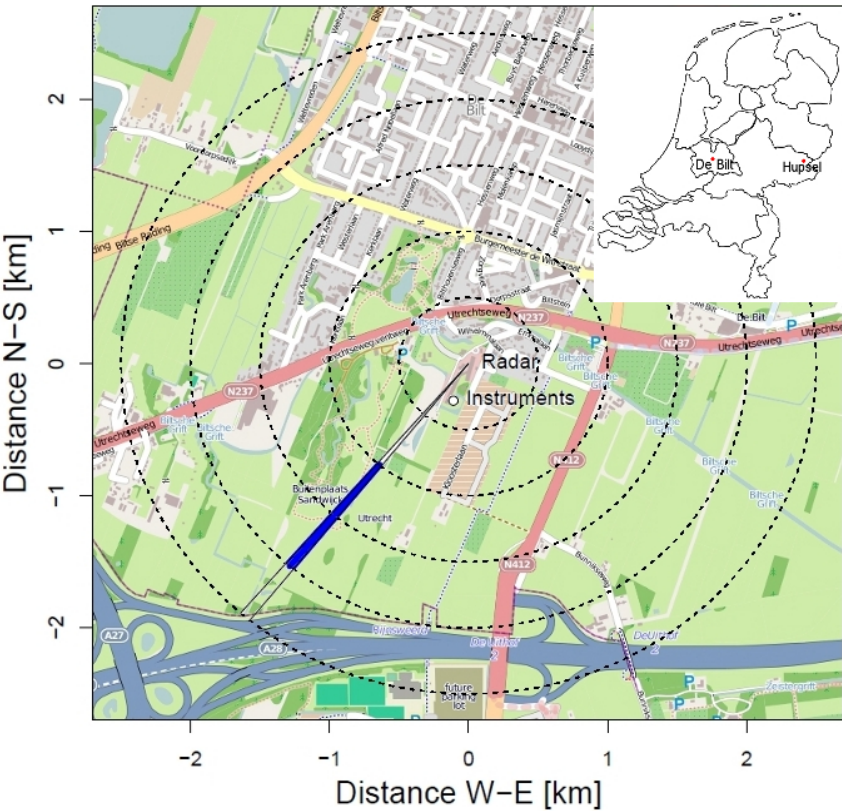
Figure 1. Locations of the rain gauge, disdrometer and radar at De Bilt with 0.5km range rings around the radar (dashed lines). The blue section is the 1–2km radar bin that is used in this study. The inset in the upper right corner shows the locations of radar and instruments at De Bilt and at Hupsel, which is the location of maximum rainfall measured during the event studied. Data by OpenStreetMap.org contributors under CC BY-SA 2.0